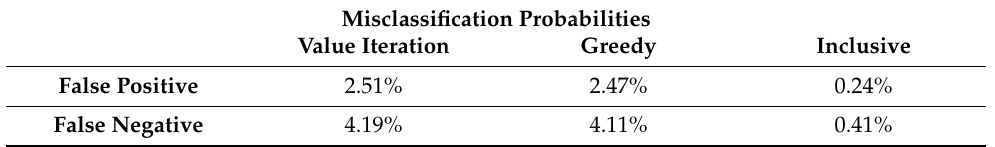
Table 2. Activation costs and accuracy results.